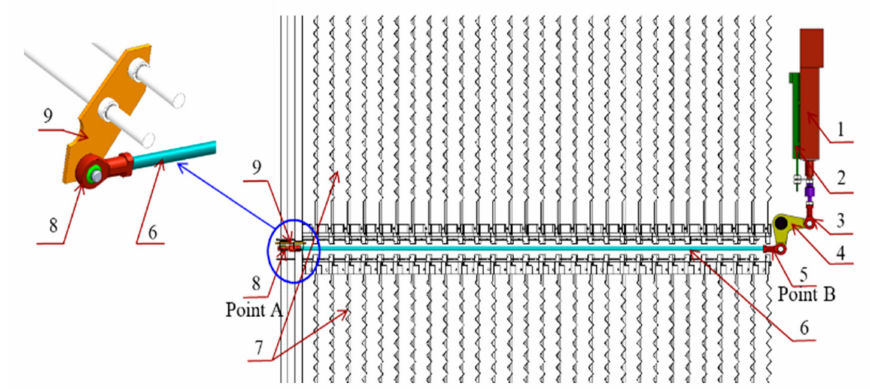
Figure3. Adaptiveadjustmentdeviceforthelouversieveopening. ( 1 )Electriccylinder, ( 2 )Displacement sensor, ( 3 ) Ball bearing, ( 4 ) Triangular block, ( 5 ) Ball bearing (Point B), ( 6 ) Pull rod, ( 7 ) Louver sieve, ( 8 ) Joint bearing (Point A) connector, ( 9 ) Adjusting